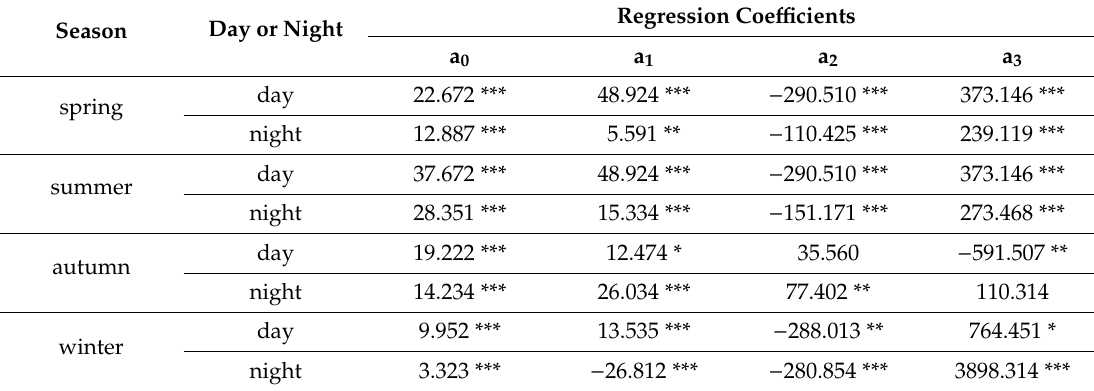
Table 2. The regression coe ffi cients of the TsHARP models during day and night in four seasons. Regression Coe ffi cients Season Day or Night a 0 a 1 a 2 a 3 day 22.672 *** 48.924 *** − 290.510 *** 373.146 *** spring night 12.887 *** 5.591 ** − 110.425 *** 239.119 *** day 37.672 *** 48.924 *** summer night day − 591.507 ** autumn night 14.234 *** 26.034 *** day 9.952 *** 13.535 *** 764.451 * winter 3.323